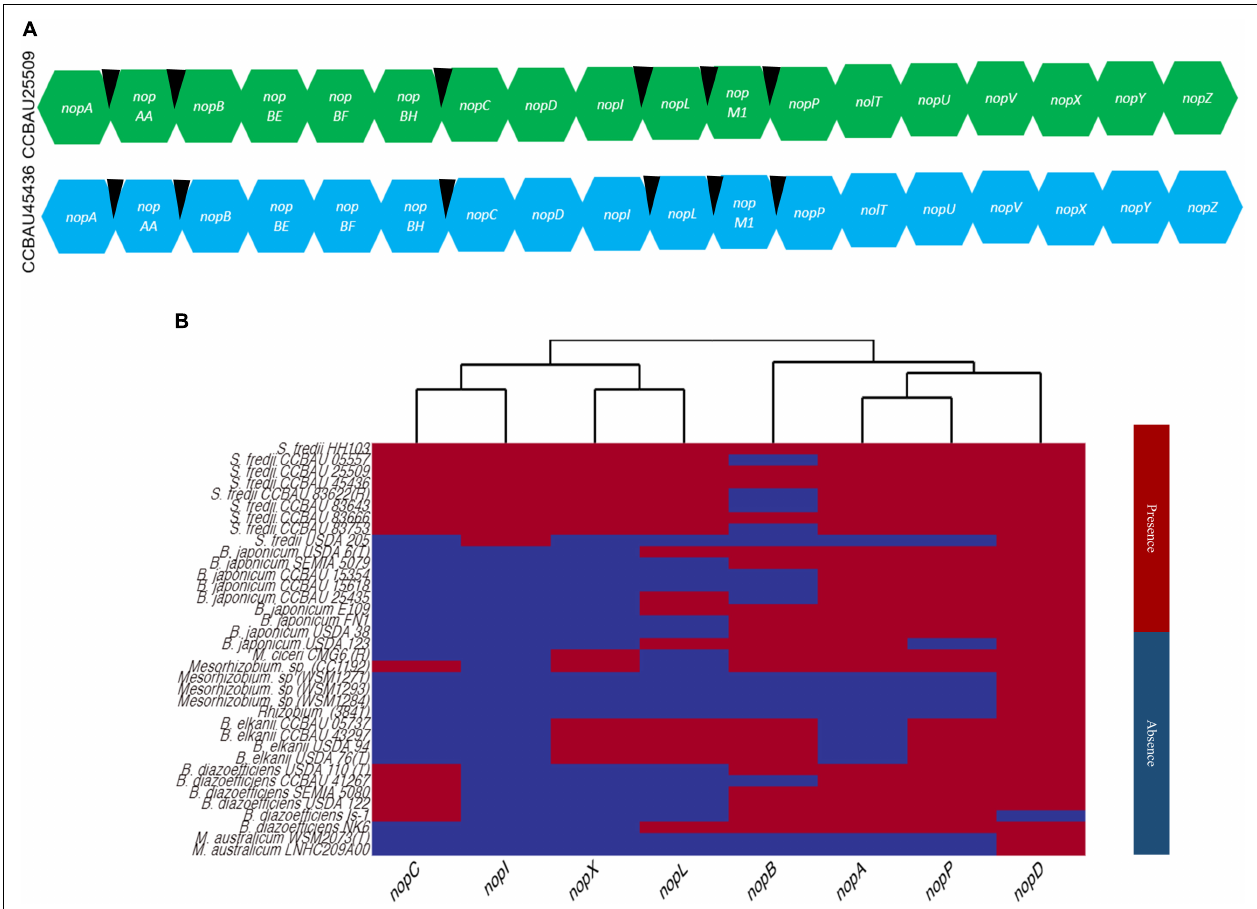
FIGURE 3 | Known and putative nop genes identified in S. fredii CCBAU25509 and CCBAU45436 and the distribution of eight nop genes in 37 rhizobial strains. (A) Known and putative nop genes identified in the genomes of both S. fredii strains. Black wedges indicate the presence of tts boxes in the upstream regions of corresponding genes. (B) Cladogram showing the distribution of eight well-characterized nop genes in the genomes of 43 rhizobial strains belonging to four genera. Red and blue color indicate the presence or absence of a specific nop , respectively, in a particular